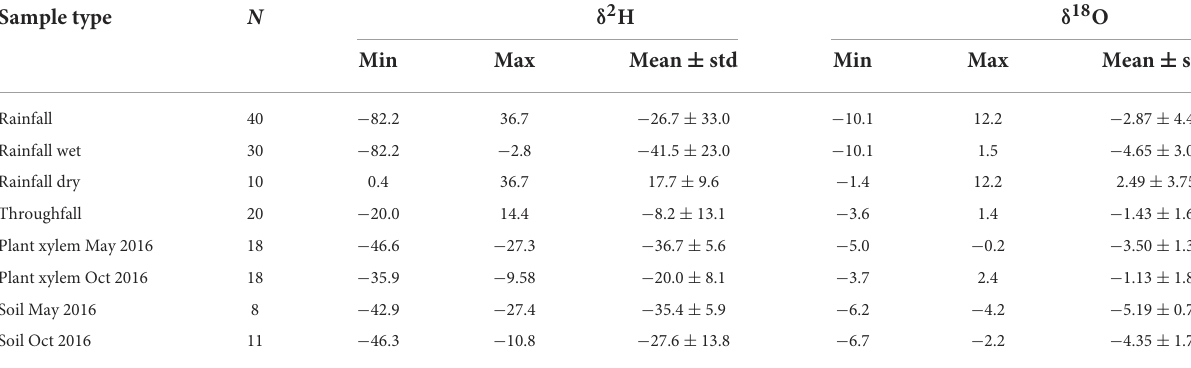
TABLE 3 Minimum (Min), maximum (Max) and average (Mean) values (including standard deviation, ± std) for all the isotopic data measured, where N is the number of samples. Sample